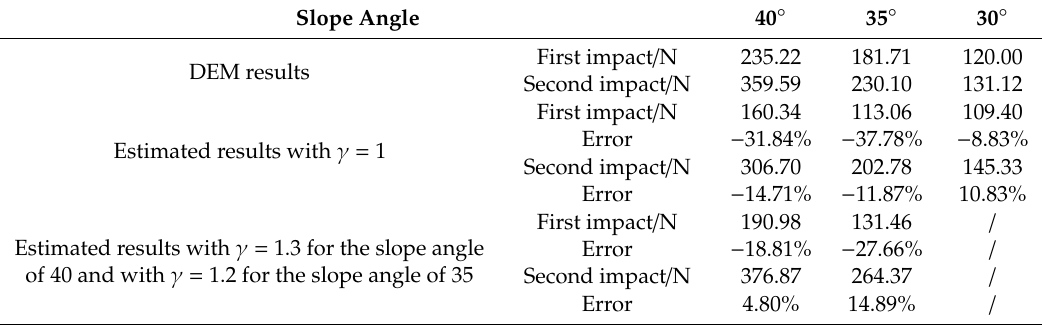
Table 6. Peak impact force estimated by the depth-averaged